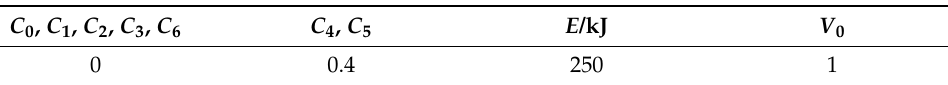
Table 8. State equation parameters of air.